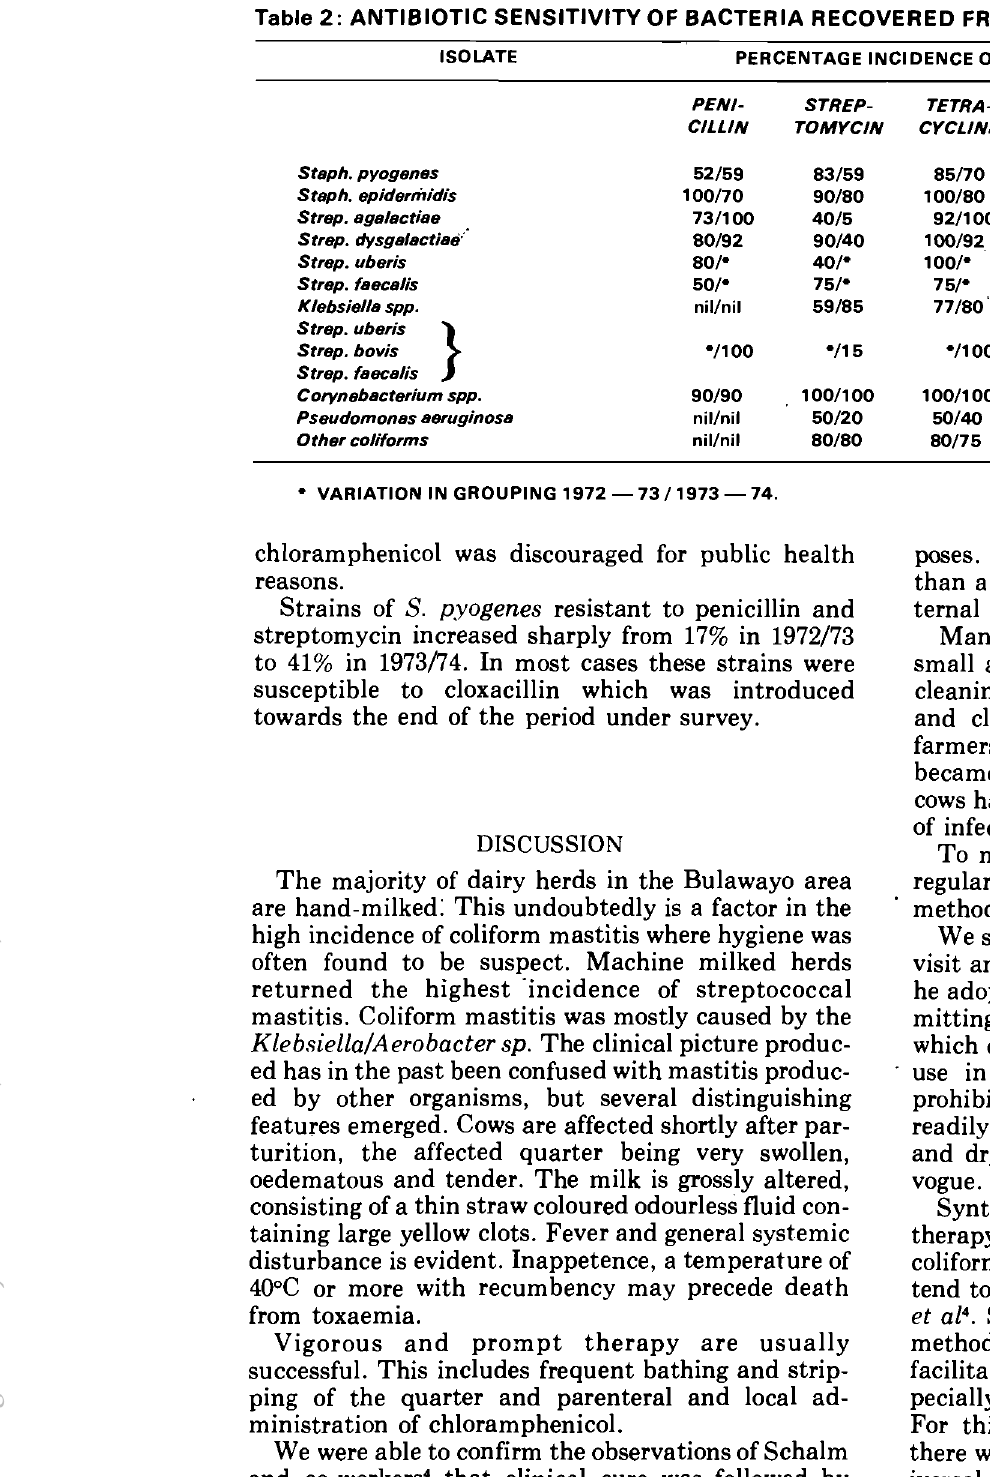
Table 2: ANTIBIOTIC SENSITIVITY OF BACTERIA RECOVERED FROM MASTITIC